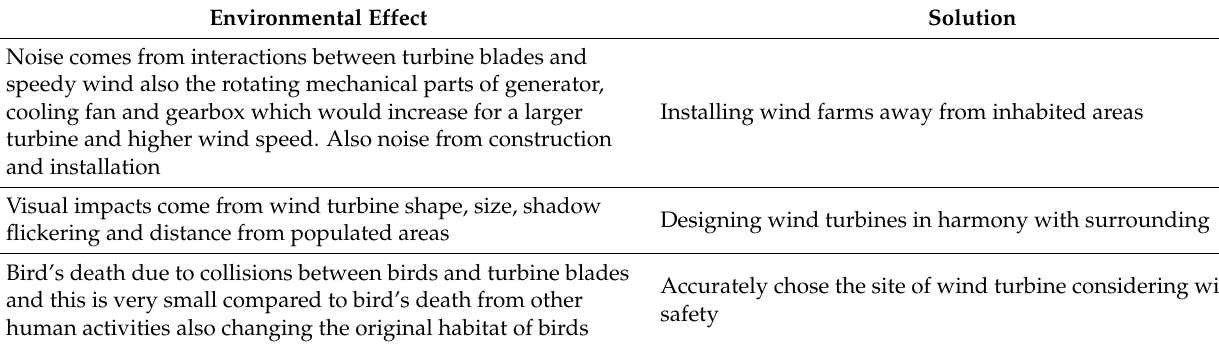
Table 1. wind energy environmental impact and